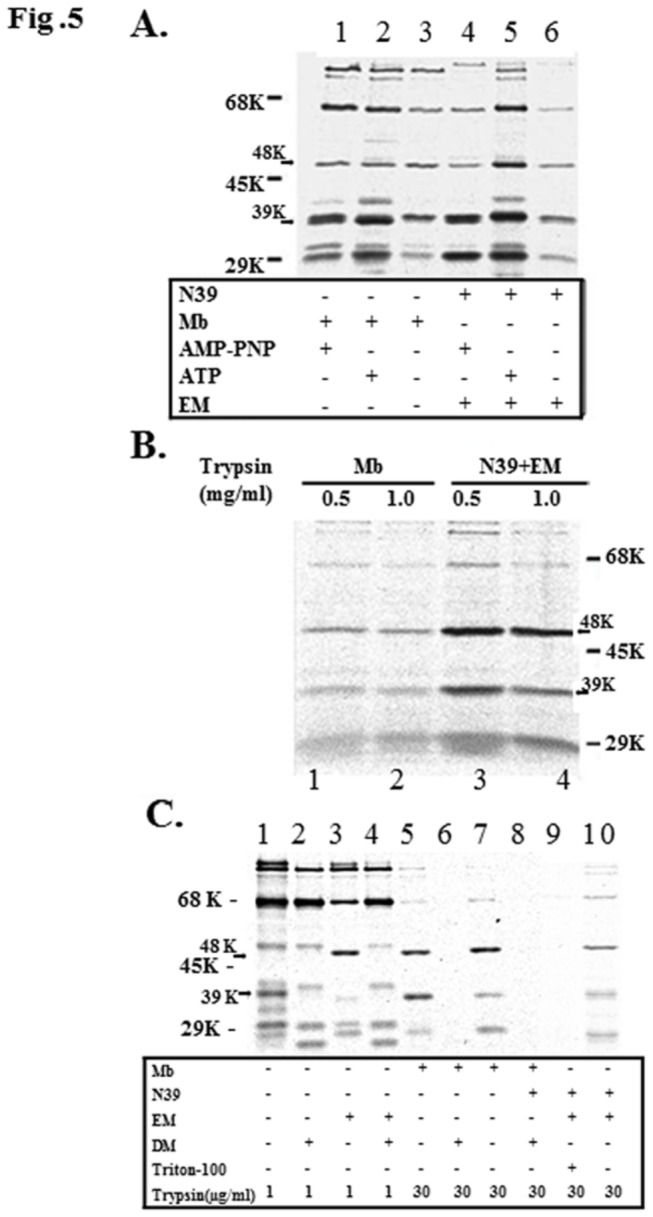
Characterization of the protease-resistant domains from membrane or EM-associated SecA.(A) The effect of nucelotide binding on the stability of the M48 domain was determined using similar proteolysis reaction conditions to those undertaken in Fig. 4, except in the presence of 2 mM ATP or AMP-PNP and 4 mM Mg(OAc)2. (B) The stabilization effect of membranes and N39 with EM on the M48 domain was assayed using proteolytic reactions to those carried out in panel A at the trypsin concentrations indicated. (C) The effect that integrity of the membrane has upon stability of the M48 domain was ascertained by undertaking proteolysis at different concentration of trypsin in the presence of Triton-X100 (1%) or malto-dodecylmaltoside (DM, 2%) as indicated. Reaction conditions used were similar to those defined in panel A.